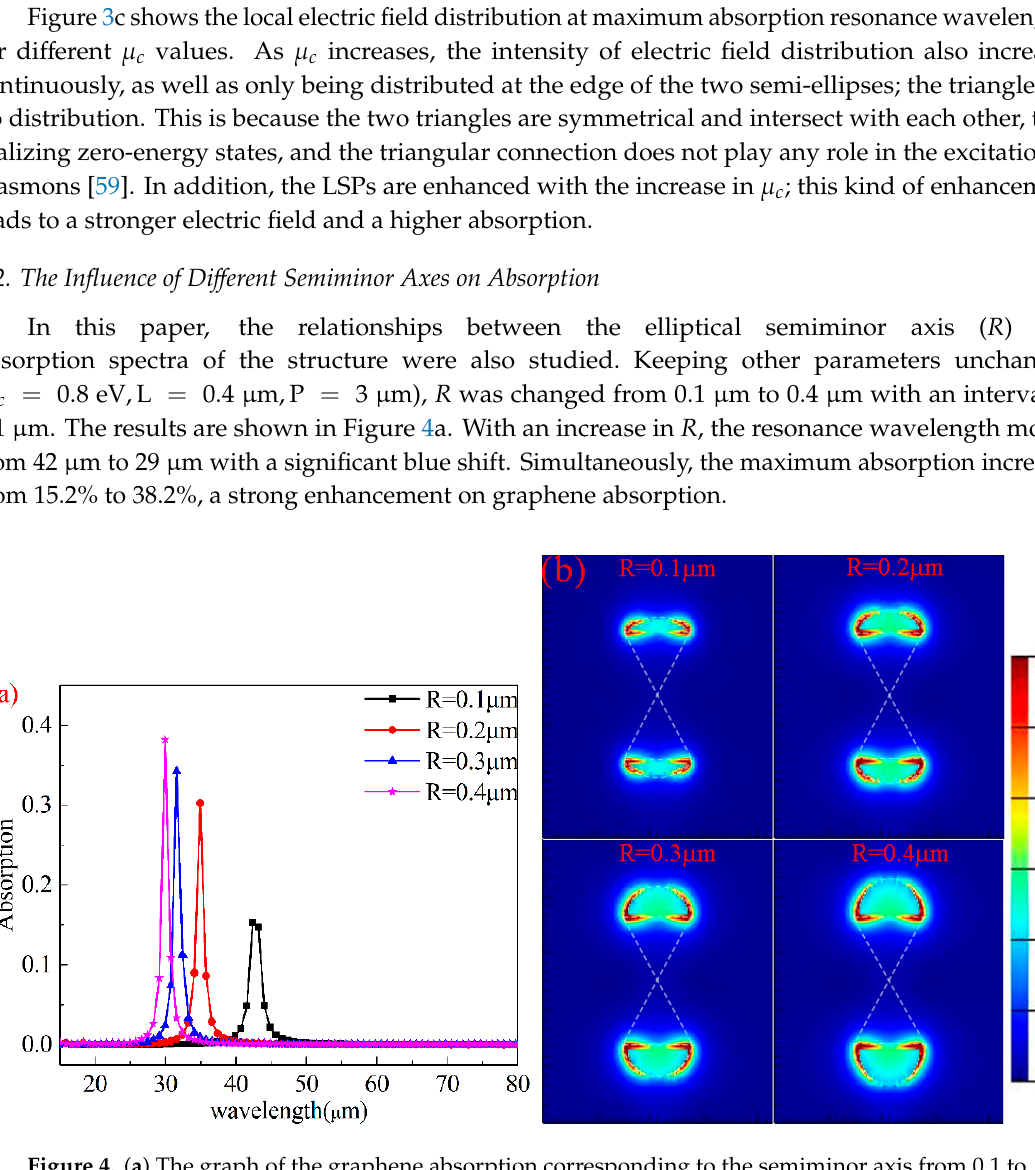
Figure 4. ( a ) The graph of the graphene absorption corresponding to the semiminor axis from 0.1 to 0.4 m μ . ( b ) The corresponding electric field intensity distribution under different R values.